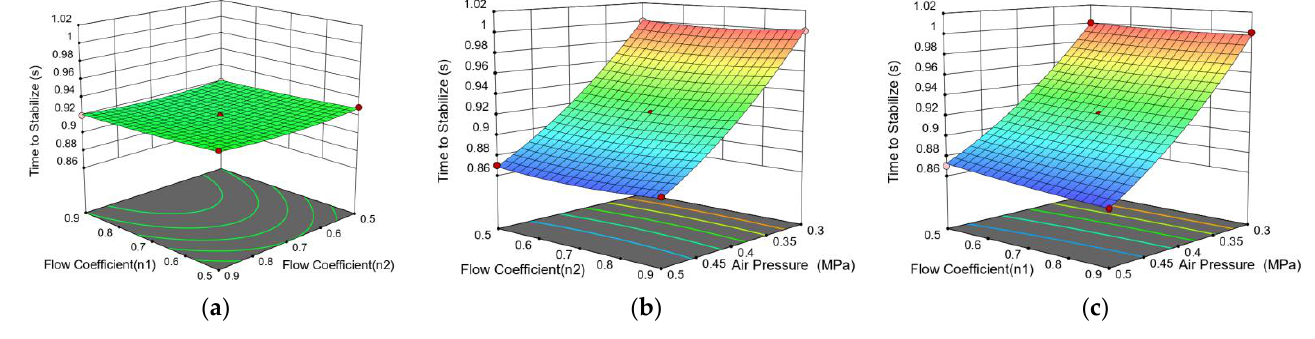
Figure 7. ( a ) Response surface of the effect of 𝑛 1 and 𝑛 2 on the time taken for cylinder stabilization when 𝑝 1 = 0.4 MPa; ( b ) response surface of the effect of 𝑝 1 and 𝑛 2 on the time taken for cylinder stabilization when 𝑛 1 = 0.7; ( c ) response surface of the effect of 𝑝 1 and 𝑛 1 on the time taken for cylinder stabilization when 𝑛 2 = 0.7.